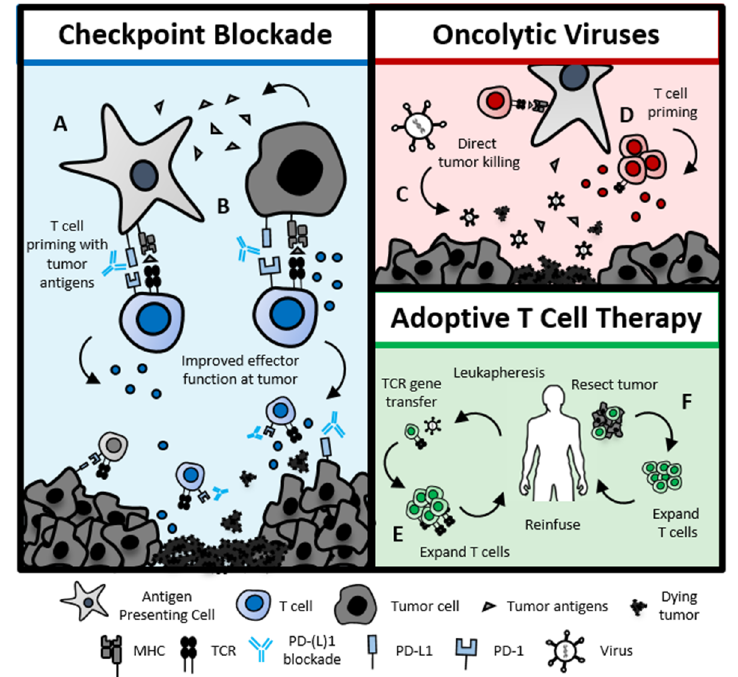
Figure 3. Immunotherapies for head and neck cancers. Checkpoint blockade: ( A ) Programmed cell death protein 1 ligand (PD-1) or PD-L1 blockade has the potential to improve T cell activation after antigen-presenting cells present tumor antigens to T cells or ( B ) may promote T cell e ff ector function directly at the tumor. Oncolytic viruses: Infection of tumor cells with oncolytic viruses promotes tumor death ( C ) by the direct killing of tumor cells, or ( D ) by the release of tumor neoantigens and augmenting immune responses to tumor. Adoptive T cell therapy: Tumors are targeted with a patient’s own T cells, which are either ( E ) expanded directly from the tumor or ( F ) engineered with TCRs responding to tumor antigens. Abbreviations: Major Histocompatibility Complex (MHC); T cell receptor (TCR).